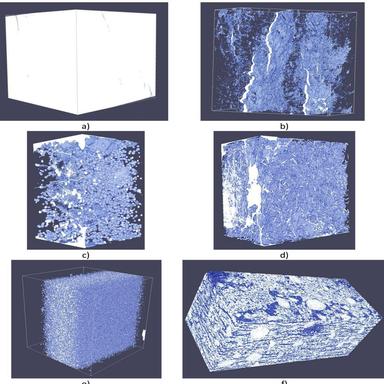
Representative 3D reconstructed computed tomography X-ray image of some of the samples tested in this study: a) reference SiC (5×5×5mm3 ); b) cracked SiC (10×10×5mm3 ); c) SiC+10 %vol. balls (5×5×8mm3 ); d) SiC+7.5 %vol. fibers (5×5×6mm3 ); e) SiC Galtenco (5×5×5mm3 ); f) SiC foam (5×5×5mm3 ).